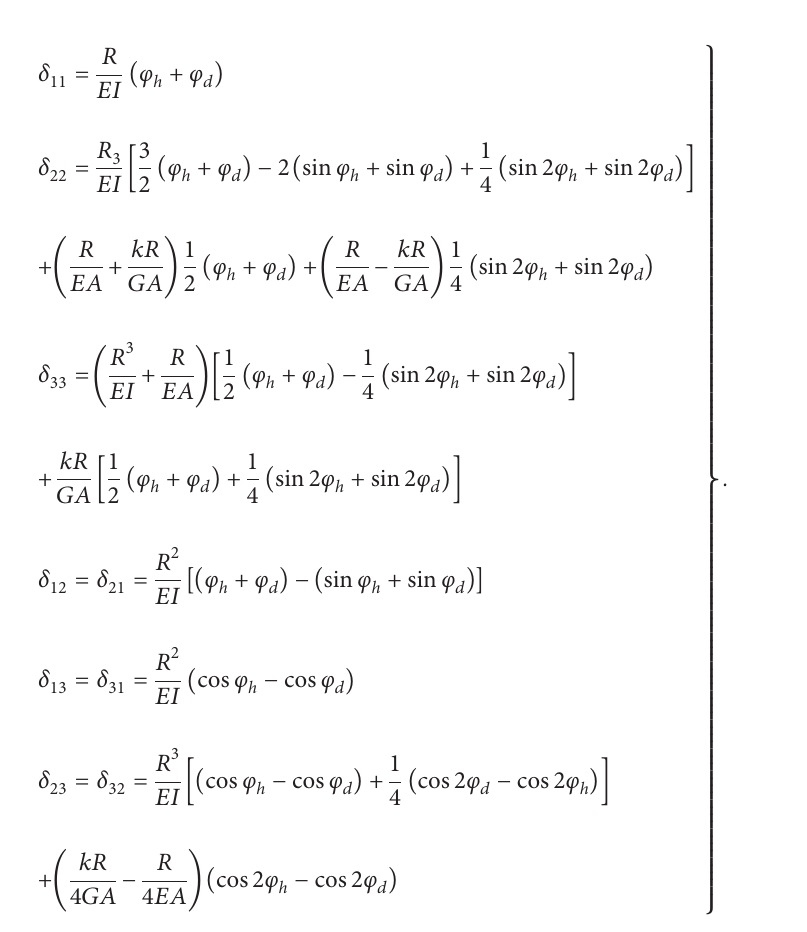
Figure 3: The basic structure of the arch ring under the unit